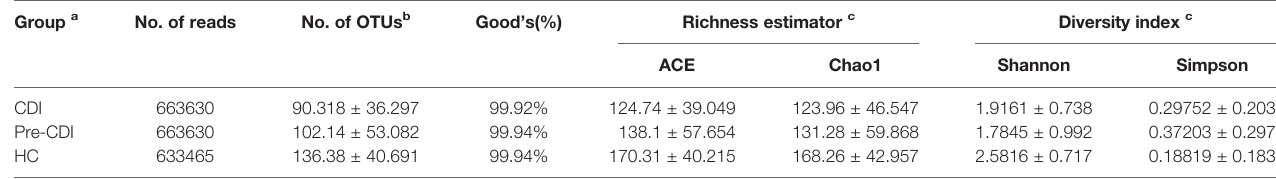
TABLE 1 | Comparison of phylotypic coverage and diversity estimates of the 16S rRNA gene libraries with 97% similarity in pyrosequencing analysis. Group a No. of reads No. of OTUs b Good ’